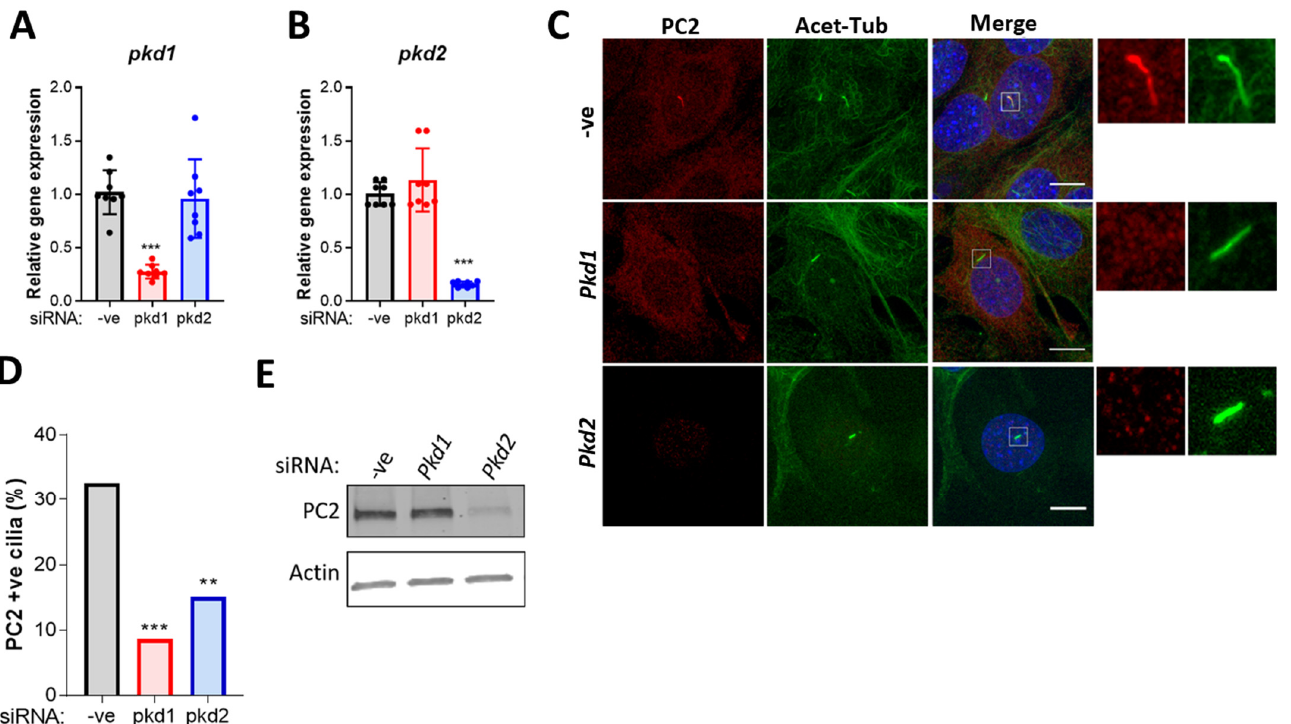
Figure 3. Immortalized murine chondrocytes were treated with siRNA for pkd1 and pkd2 and a negative control siRNA